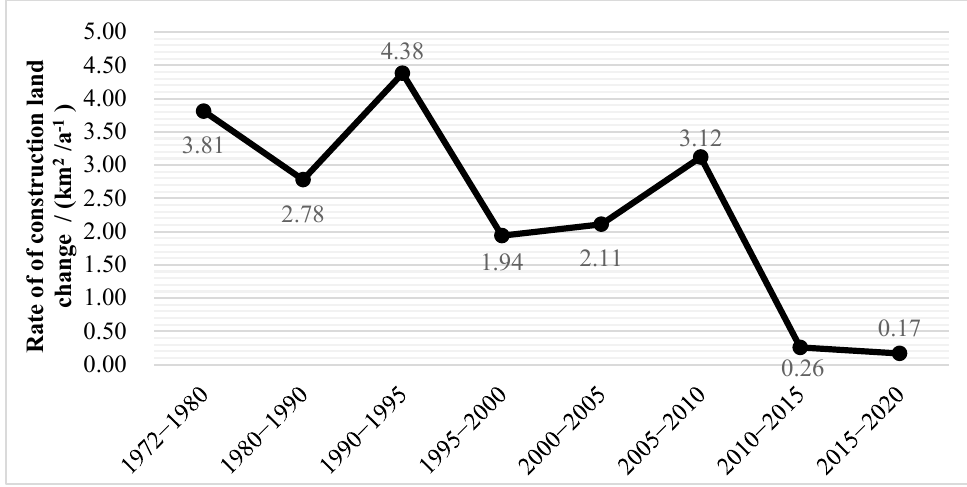
Figure 3. Line chart of the rate of change in the area of construction land in Hong Kong.